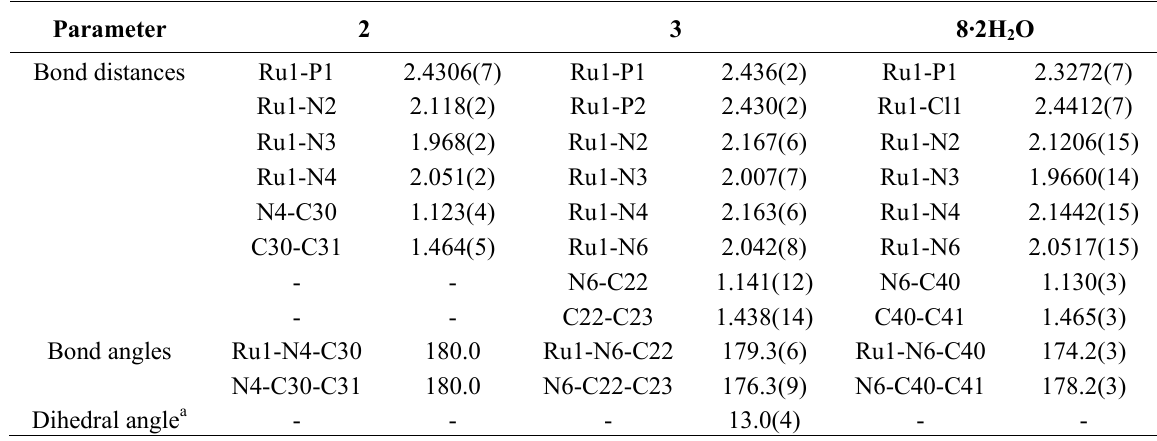
Table 2. Selected bond distances (Å) and angles (°) for 2 , 3 , and 8